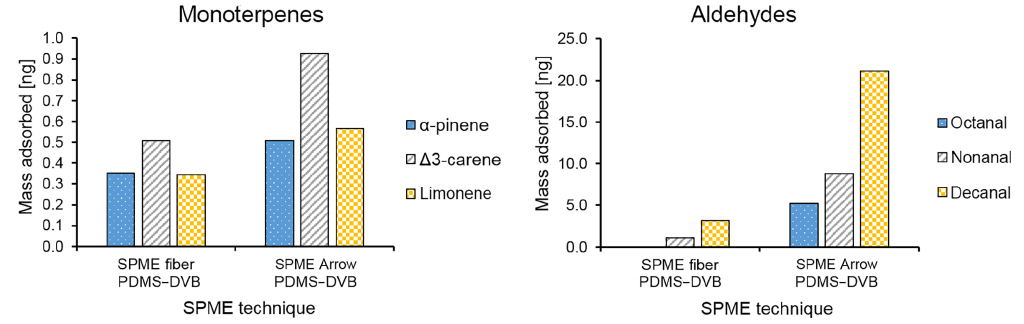
Figure 7. Comparison between the average mass of identified monoterpenes ( α -pinene, (cid:49) 3 -carene, and limonene) and aldehydes (octanal, nonanal, and decanal) collected with different PDMS–DVB SPME devices (fiber and Arrow) from ambient air and measured by GC-MS.